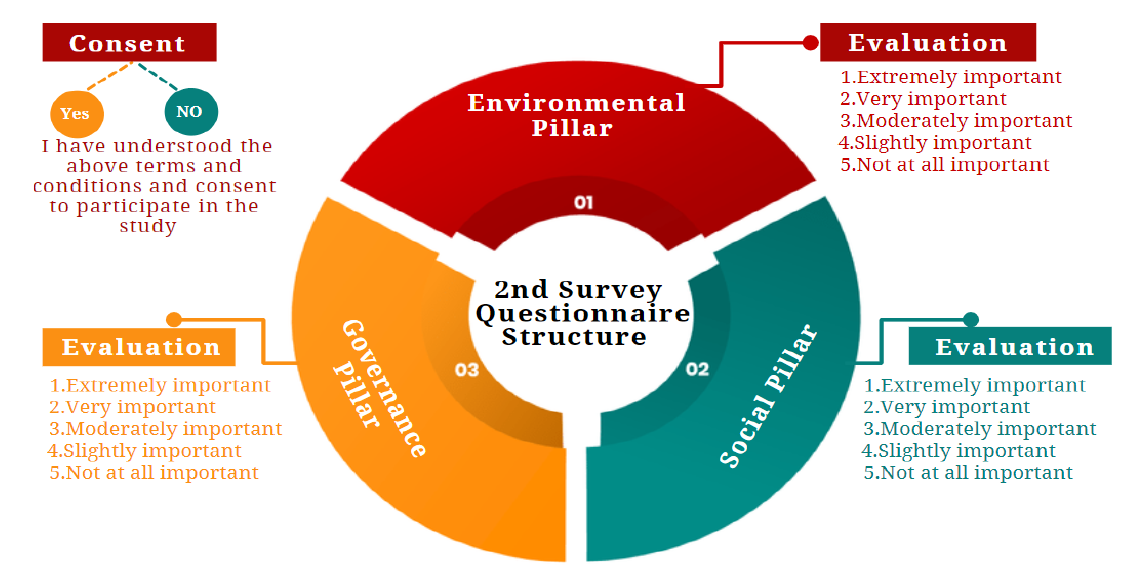
Figure 2. The research instrument used in the 2nd survey. Source: Matemane (2022).